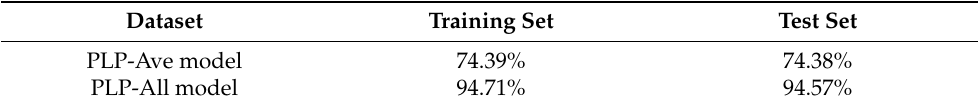
Table 4. Accuracy of PLP-Ave and PLP-All models using the SVM